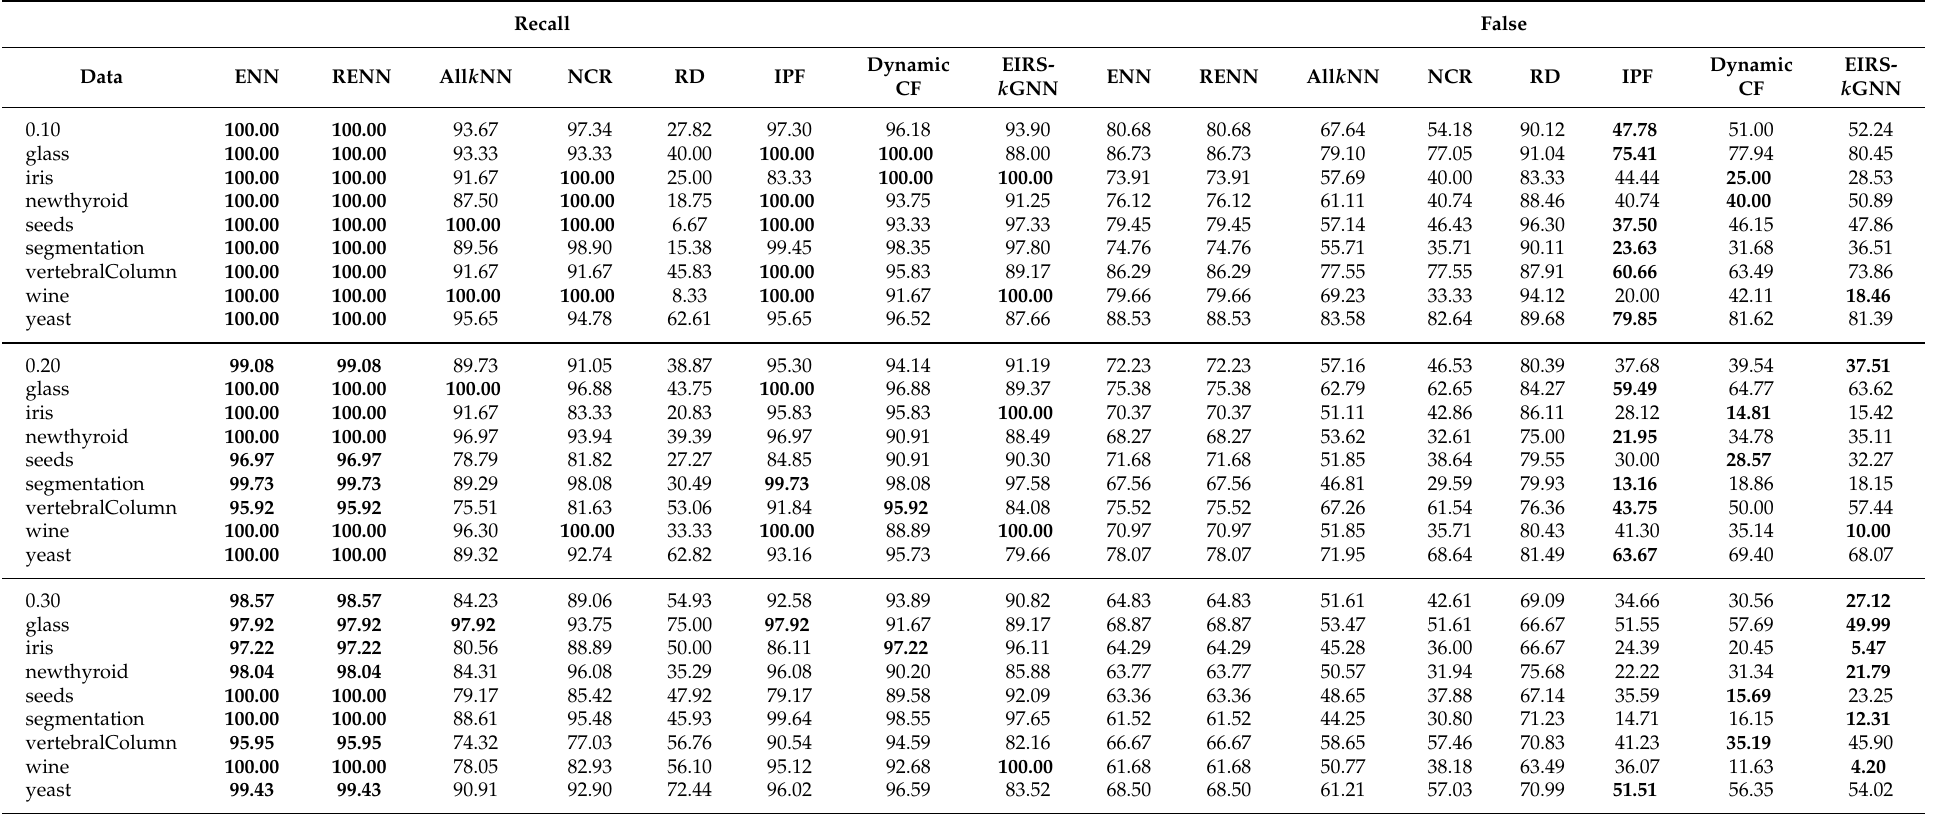
Table 6. Average results (%) comparison of label-noise detection performances on multi-class data sets at varying γ